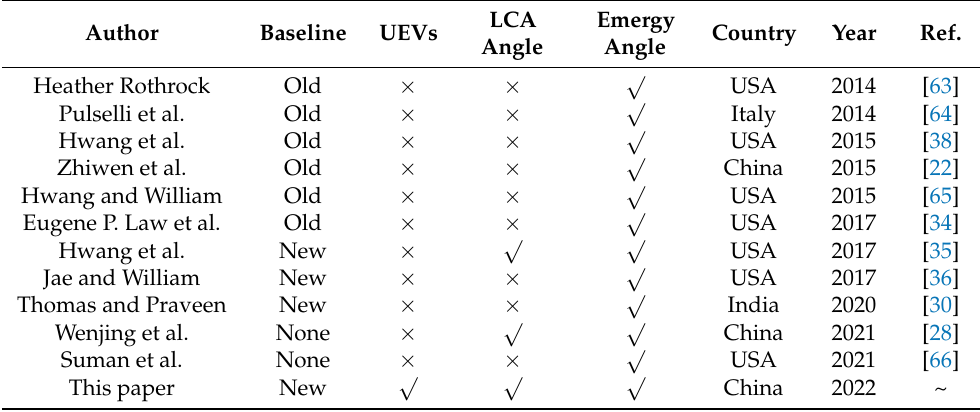
Table 9. Comparative analysis of